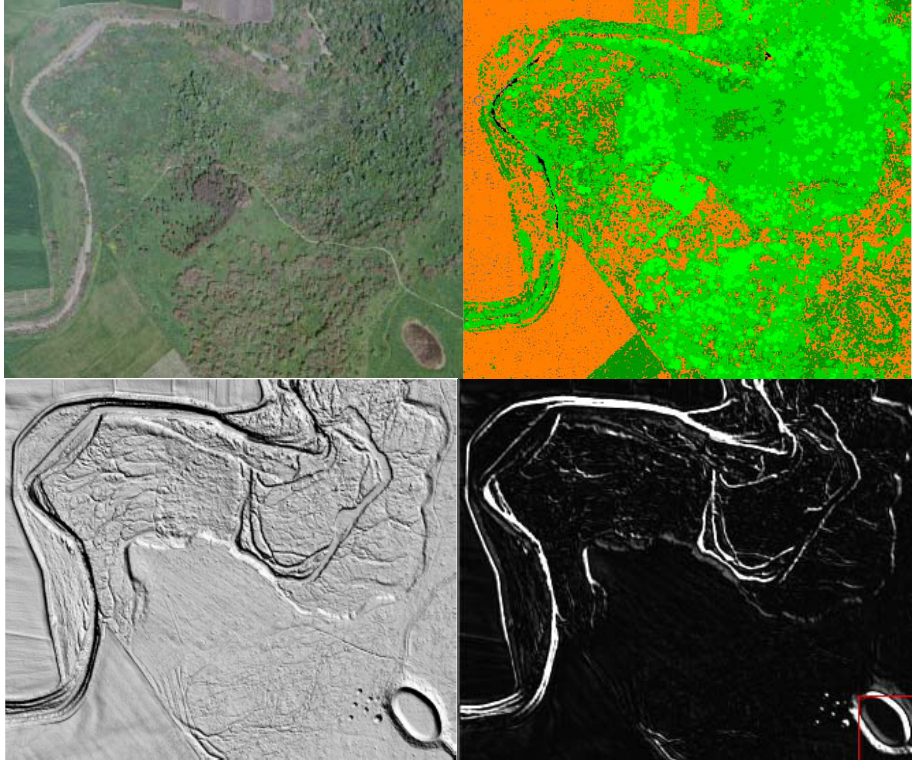
Figure 6 (upper left) orthophoto acquired at the same time as LiDAR data, (upper right) results from the classification of LiDAR raw data; (upper left) DTM which clearly shows the capability of LiDAR to penetrate the vegetation canopy, and (upper right) map from the spatial autocorrelation analysis Geary’s index